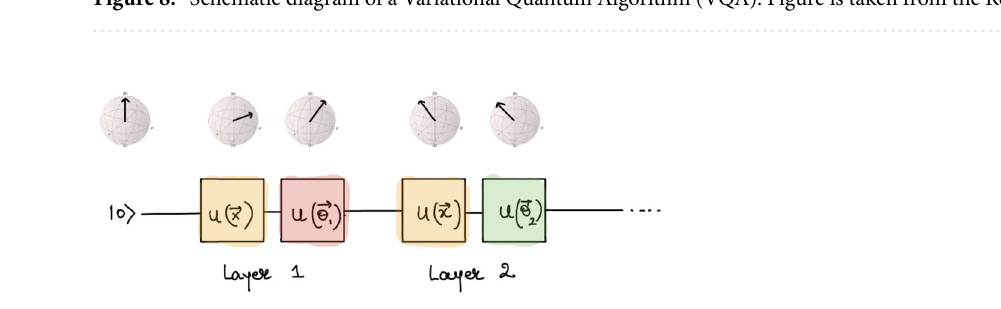
Figure 9. Quantum circuit implementing data re-uploading, each block corresponds to the layer of classical neural network. Image is taken from the online source Ref. 58